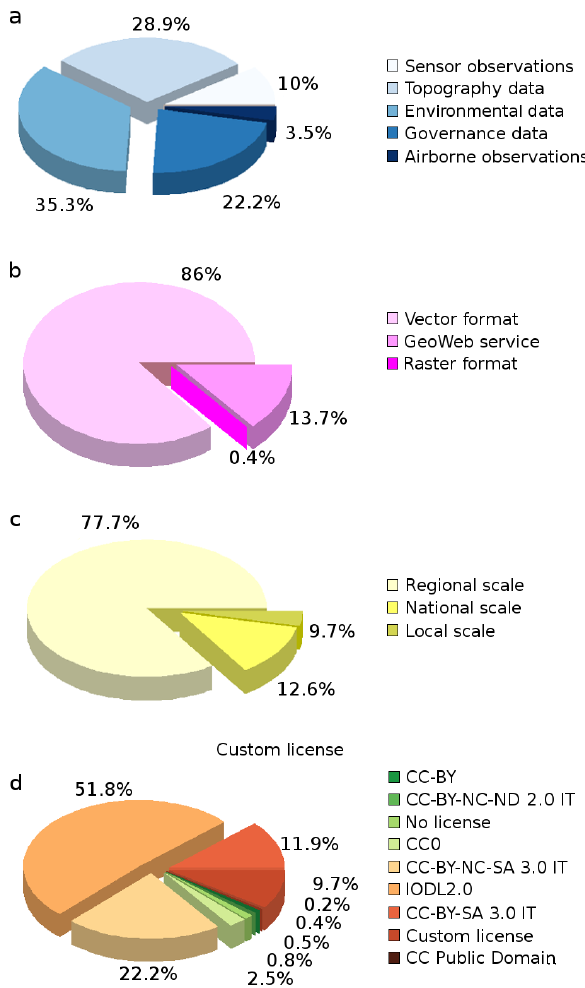
Figure 2. Classification of the open geodata available for Milan Municipality according to: category (a), format (b), scale (c) and license (d)